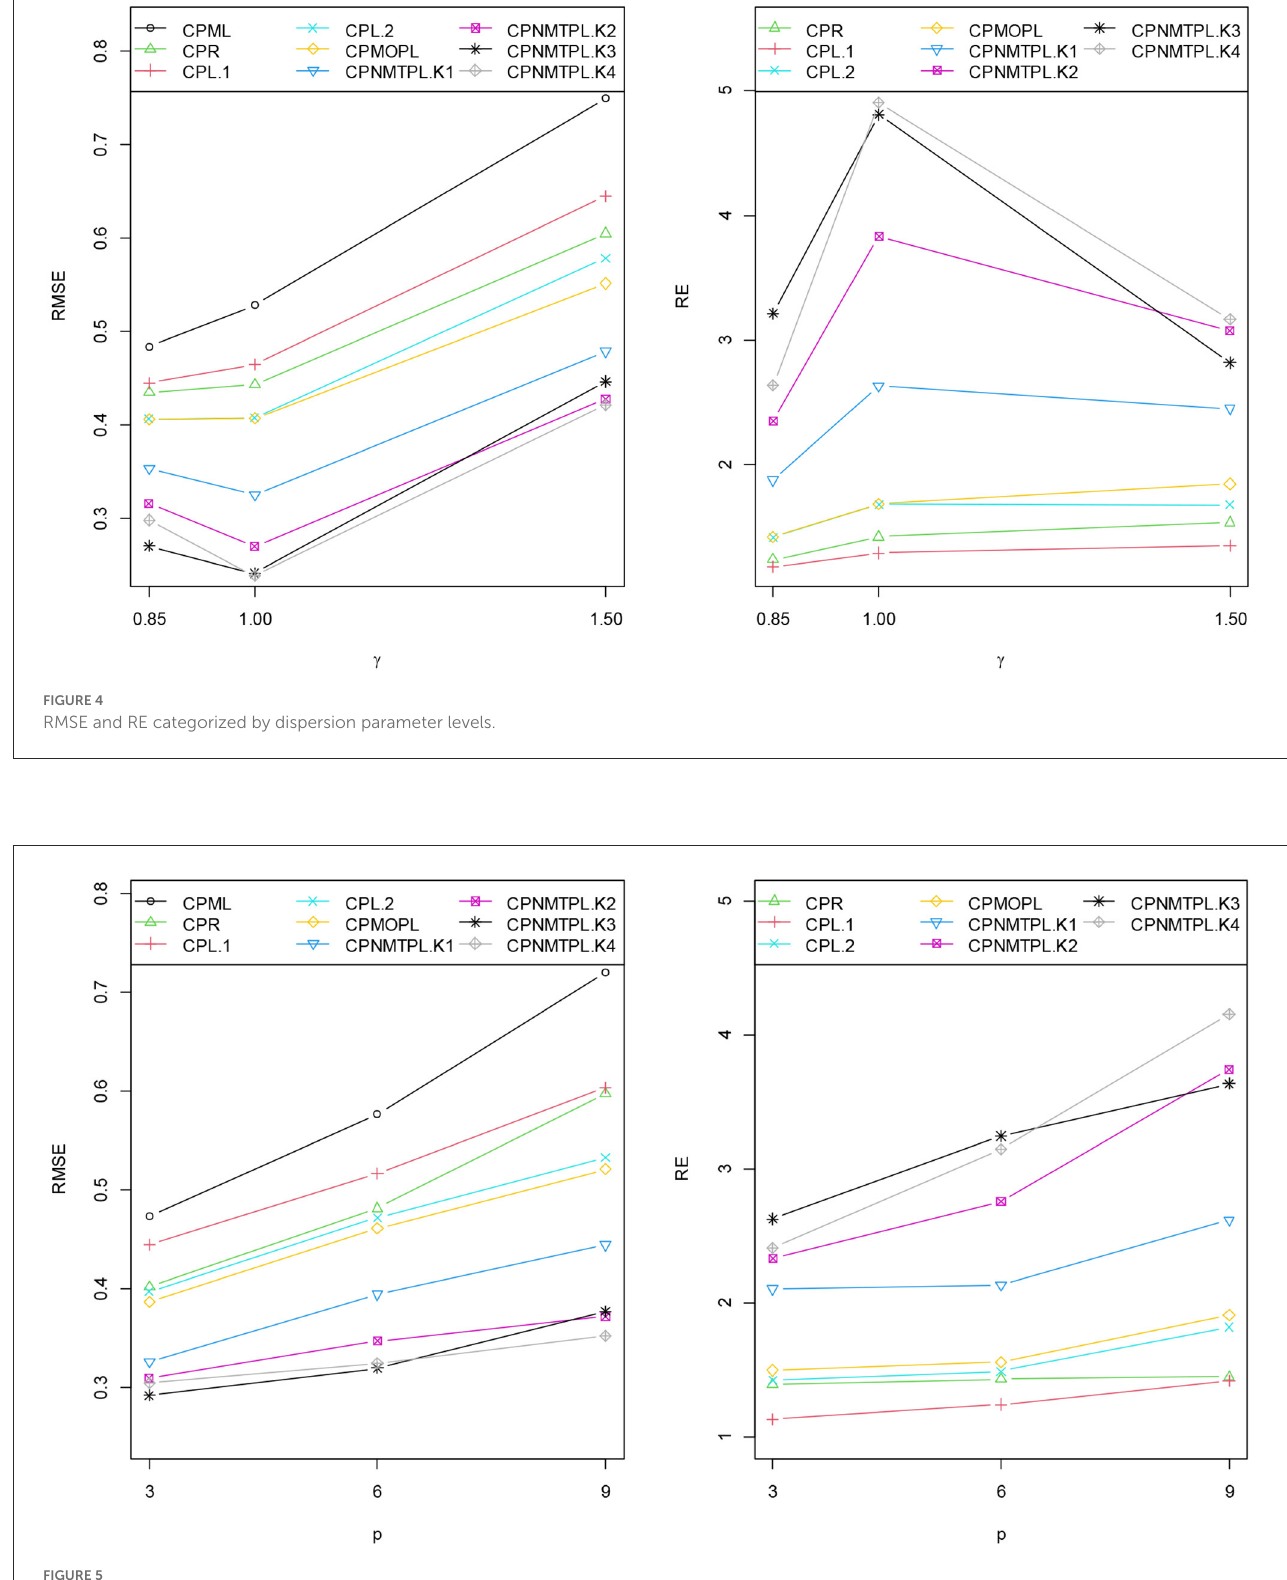
FIGURE5 RMSE and RE categorized by the number of explanatory